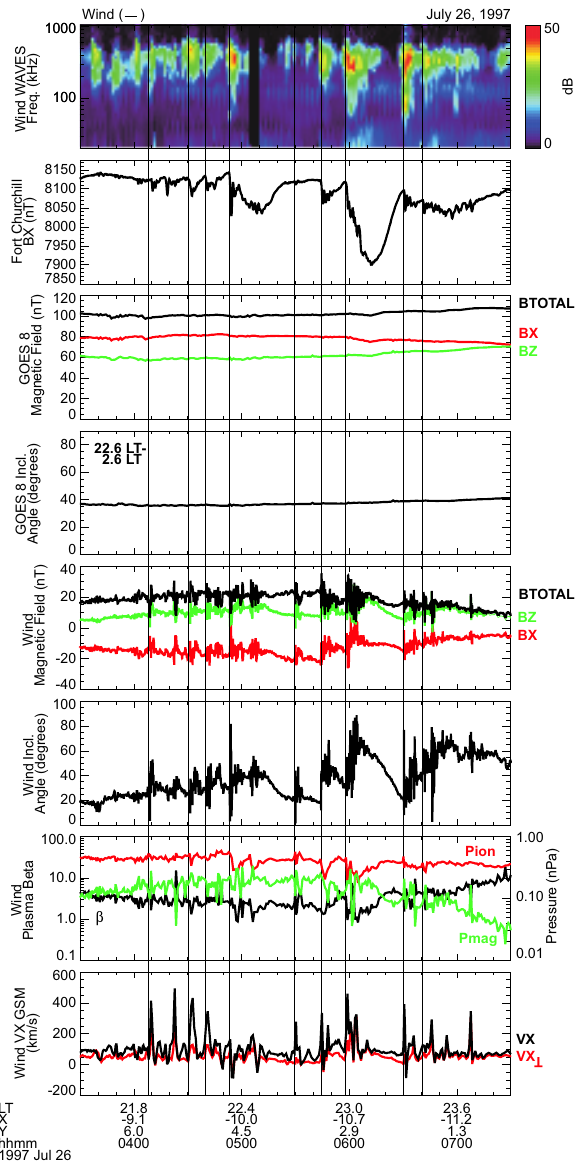
Fig. 5. Wind, CANOPUS and GOES 8 data from 03:30 to 07:30 UT on 26 July 1997. Figure 6 is the same format as Fig. 2. GOES 8 was located between 22.6 LT to 2.6 LT for the time period shown in the figure.